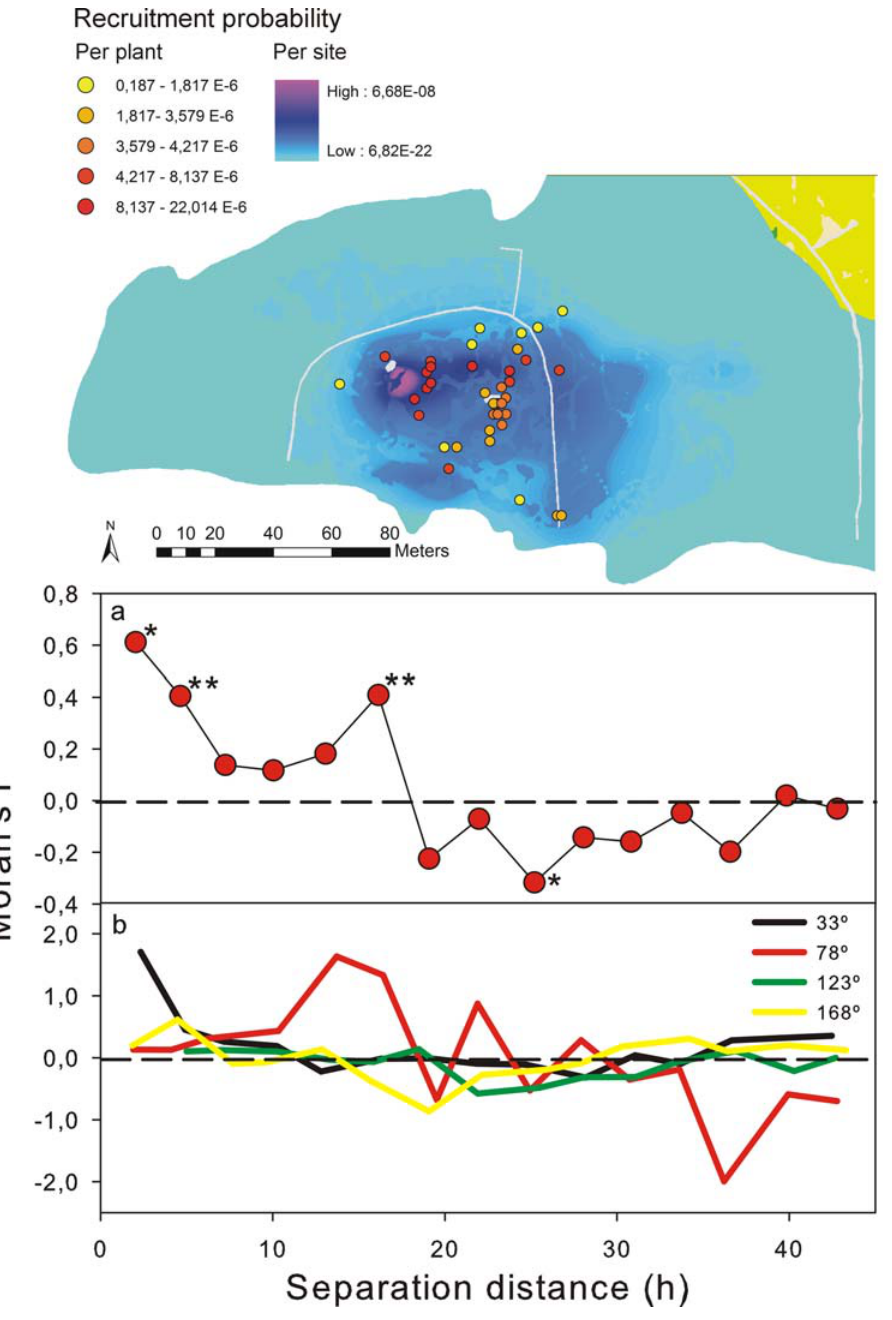
Figure 4. Mean recruitment kernel of the study population, including the average probability of recruitment of each reproductive adult. Probability of recruitment of each seed produced by the study population (including post-dispersal seed predation, seedling emergence and survival) is showed as a colour gradient. Coloured dots indicate the position and average probability of recruitment (per seed produced) of 38 reproductive adults present in the study area. The lower panels show the isotropic spatial autocorrelation (Moran’s I) of average plant recruitment. Since the data structure was strongly anisotropic, we also show anisotropic spatial autocorrelation at four directions from the centre of the recruitment kernel. Asterisks indicate distances at which Moran’s I significantly departed from zero: * p , 0.05, ** p , 0.01.